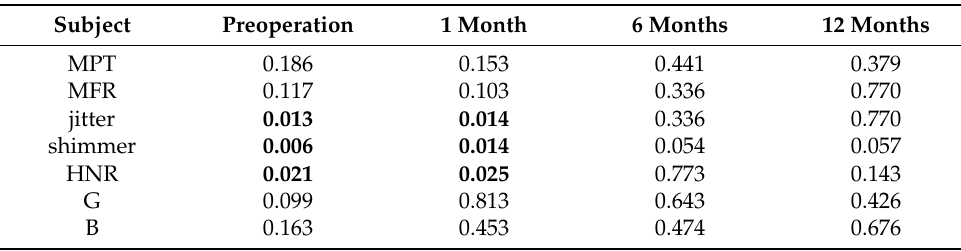
Table 3. p values of each parameters and periods in comparison between nerve interposition and nerve transfer subgroups in paralyzed-reconstruction subgroup.